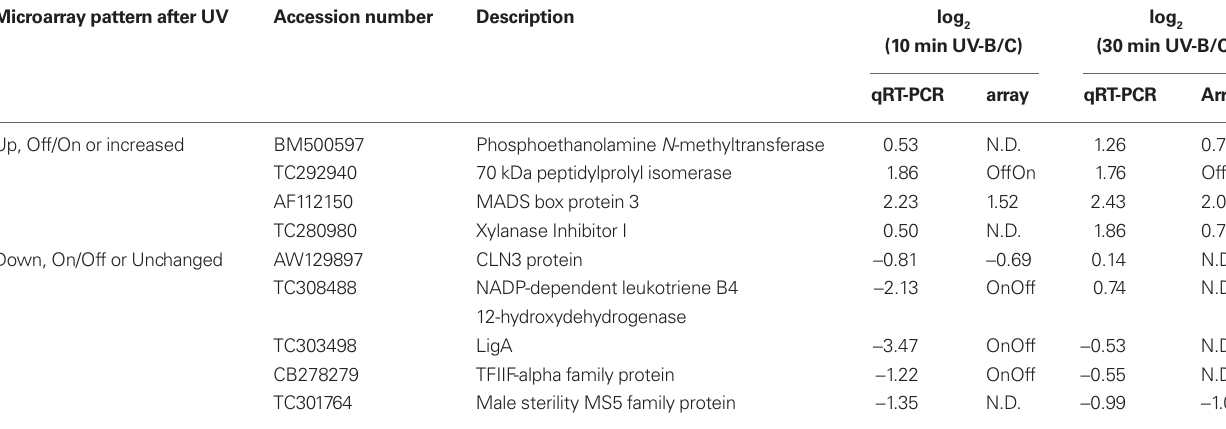
Table 4 | Confirmation of microarray data by qRT-PCR